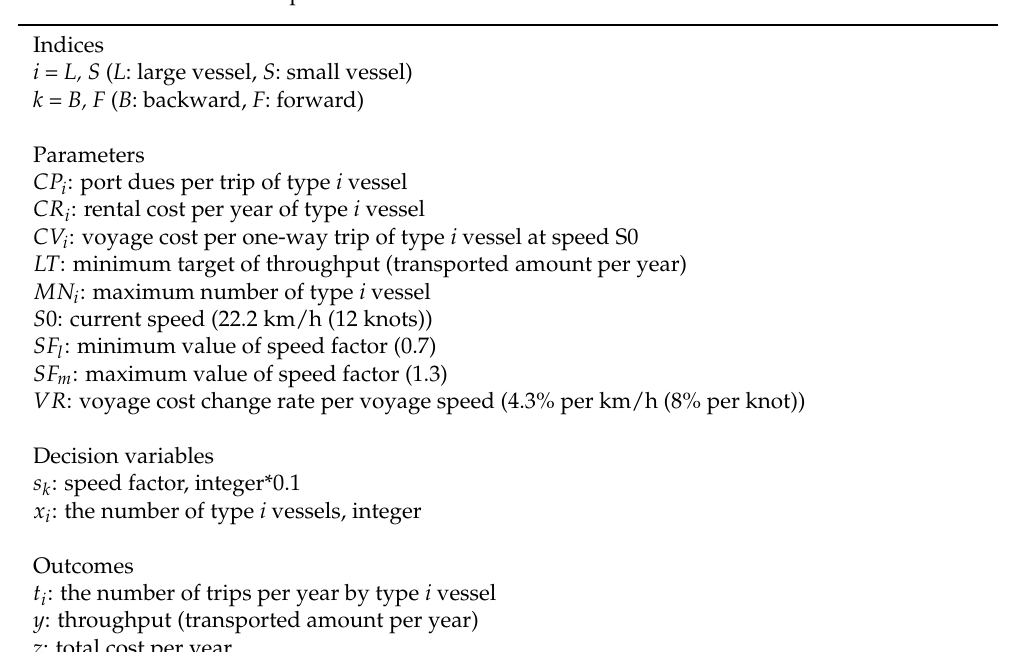
Table 1. Notations for the optimization